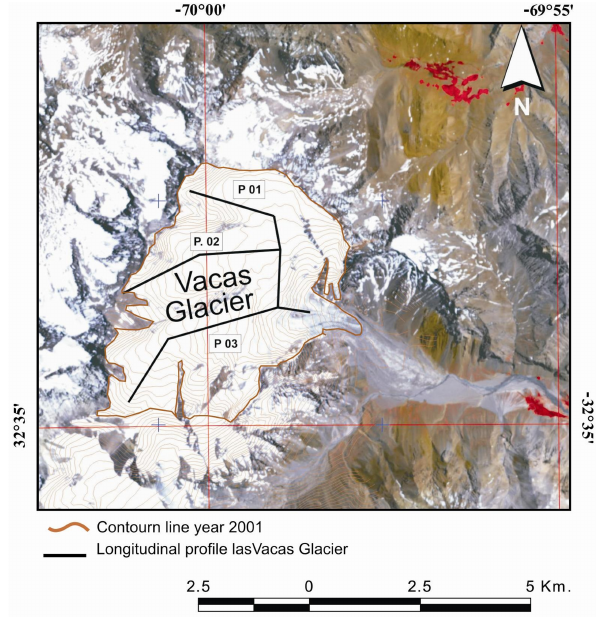
Fig. 2. Profiles along flow lines of Las Vacas